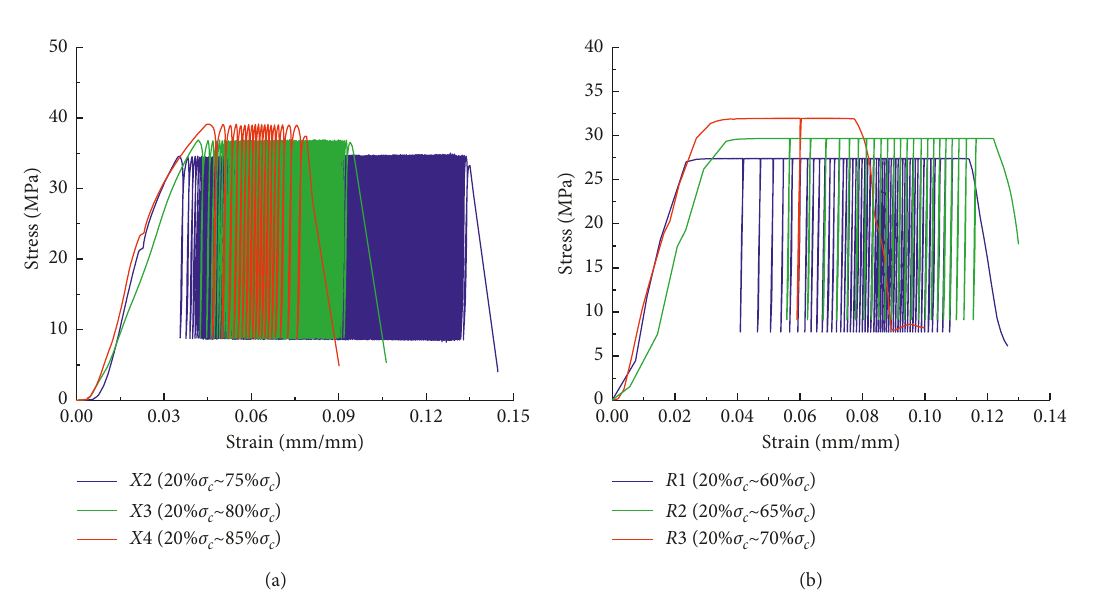
Figure 4: Stress-strain curve of rock salt. (a) Cyclic loading test and (b) cyclic creep